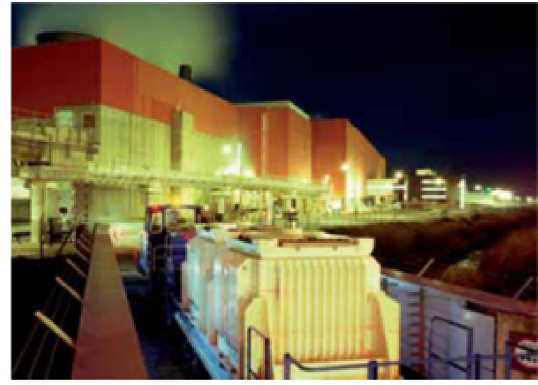
Fig. 1. Centralised storage pond (Courtesy of Sella fi eld Ltd).